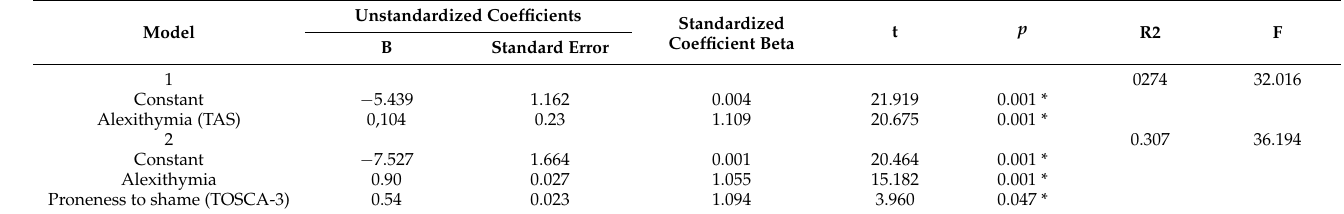
Table 6. Stepwise Logistic Regression Model and Statistics for Dependent Variable AN or